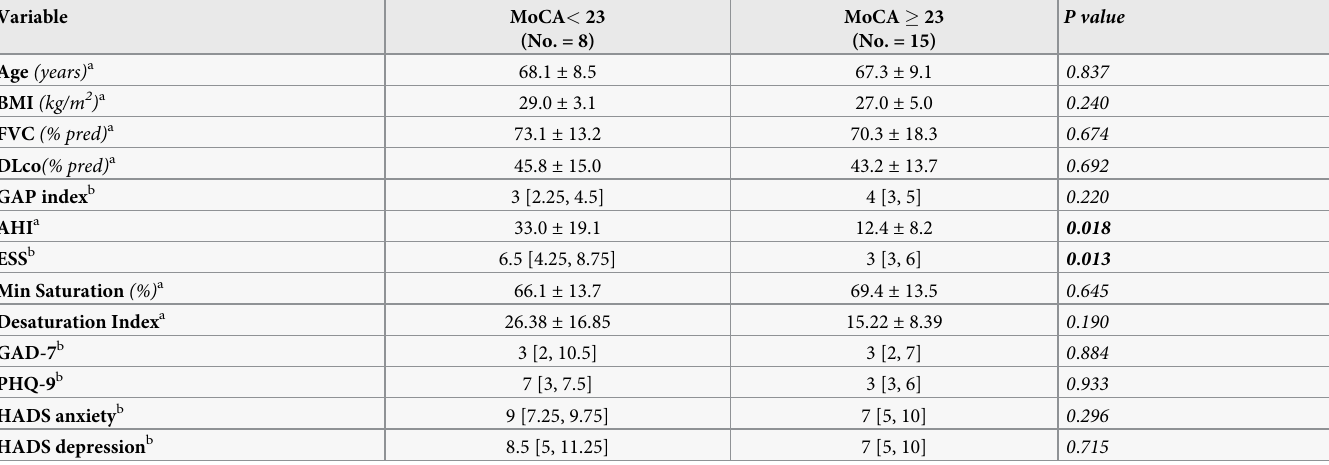
Table 2. Clinical characteristics of IPF patients stratified according to cognitive impairment.